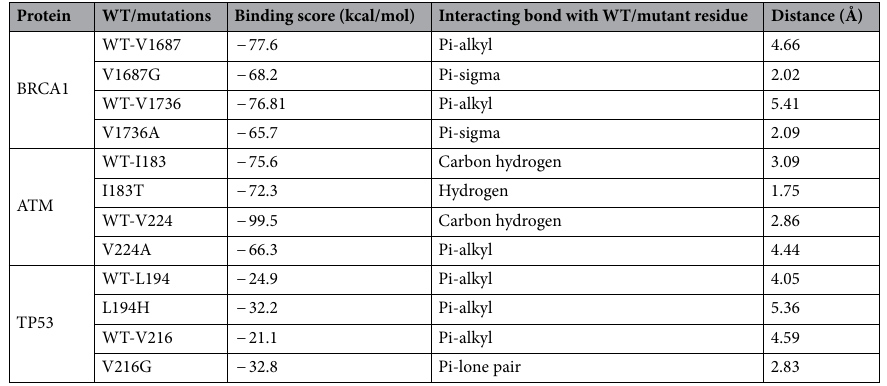
Table 5. Interactions of PK083 with six mutants along with the WT proteins of BRCA1 (BRCT domain), ATM (Catalytic domain) and p53 (DNA-Binding